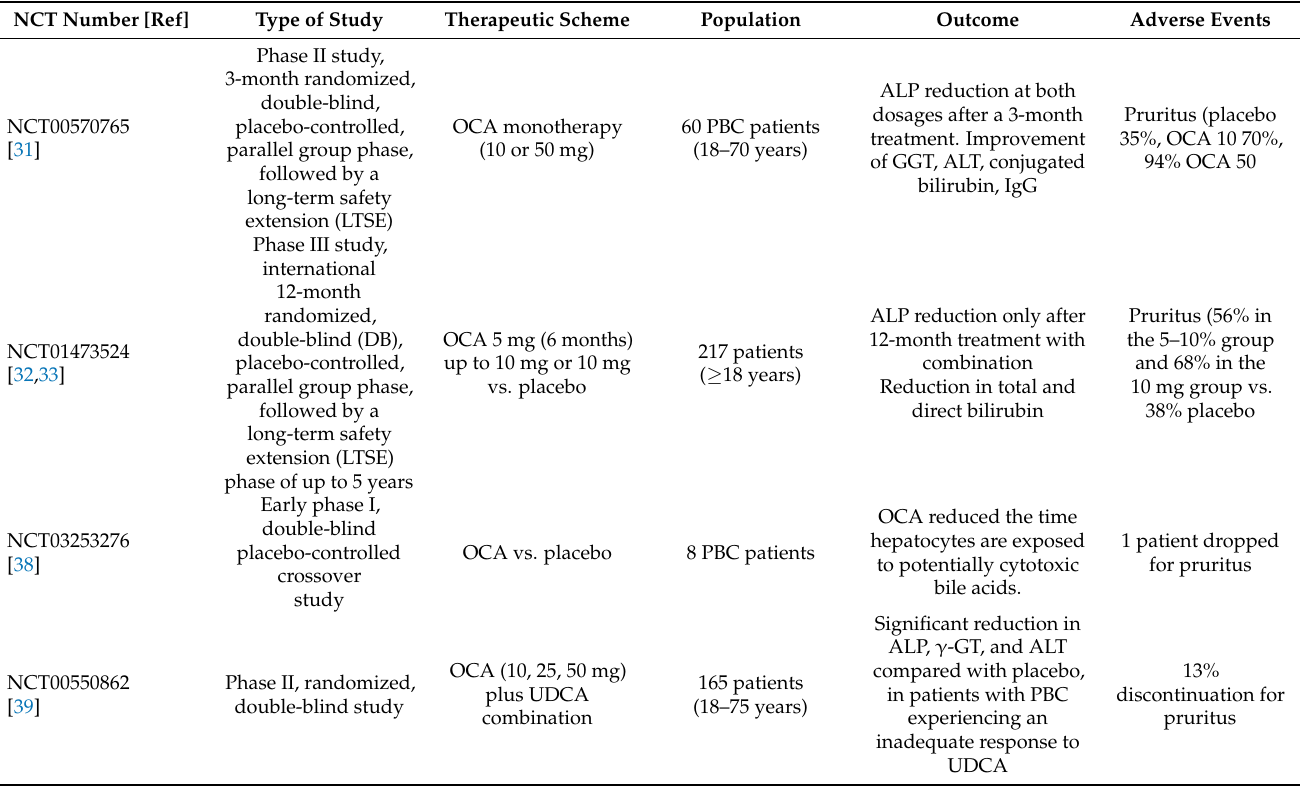
Table 1. Summary of the main pre-registration studies described in the